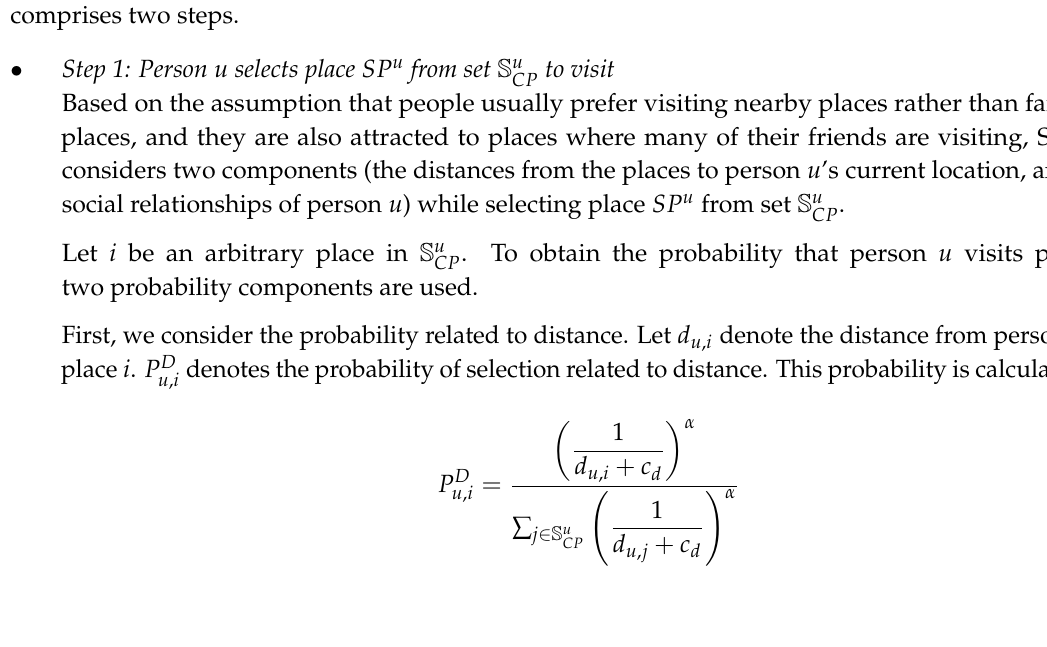
= S u ∪ S u ) for person u CS FS RS